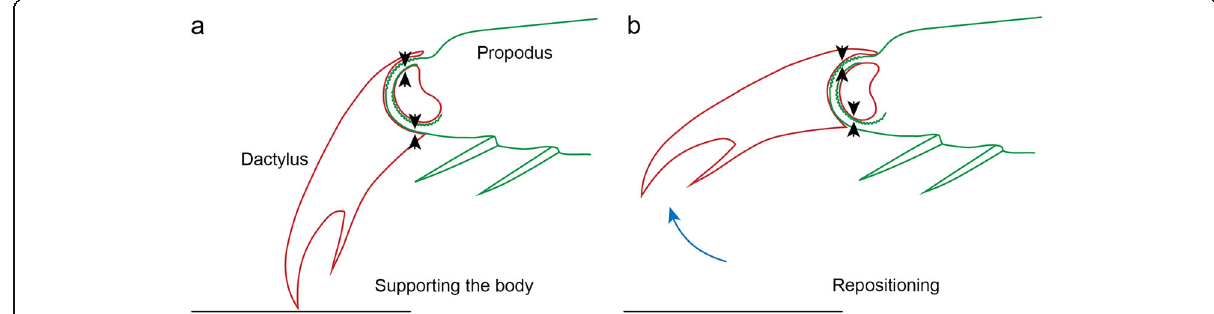
Fig. 8 Predicted loading of contacting surfaces in the propodus-dactylus joint during locomotion. a During standing and the effective stroke of the pereopod, the process of the propodus pushes against the groove of the dactylus with its smooth surfaces: the convex ventral surface and the concave dorsal surface of its edge. b During the recovery stroke, as the pereopod is lifted off the substrate and repositioned, the propodus supports the dactylus with the patterned surfaces of the propodal process: its convex dorsal surface and its concave ventral surface. The dactylus can be repositioned during this stage as it responds to the roughness of the substrate (blue arrow)